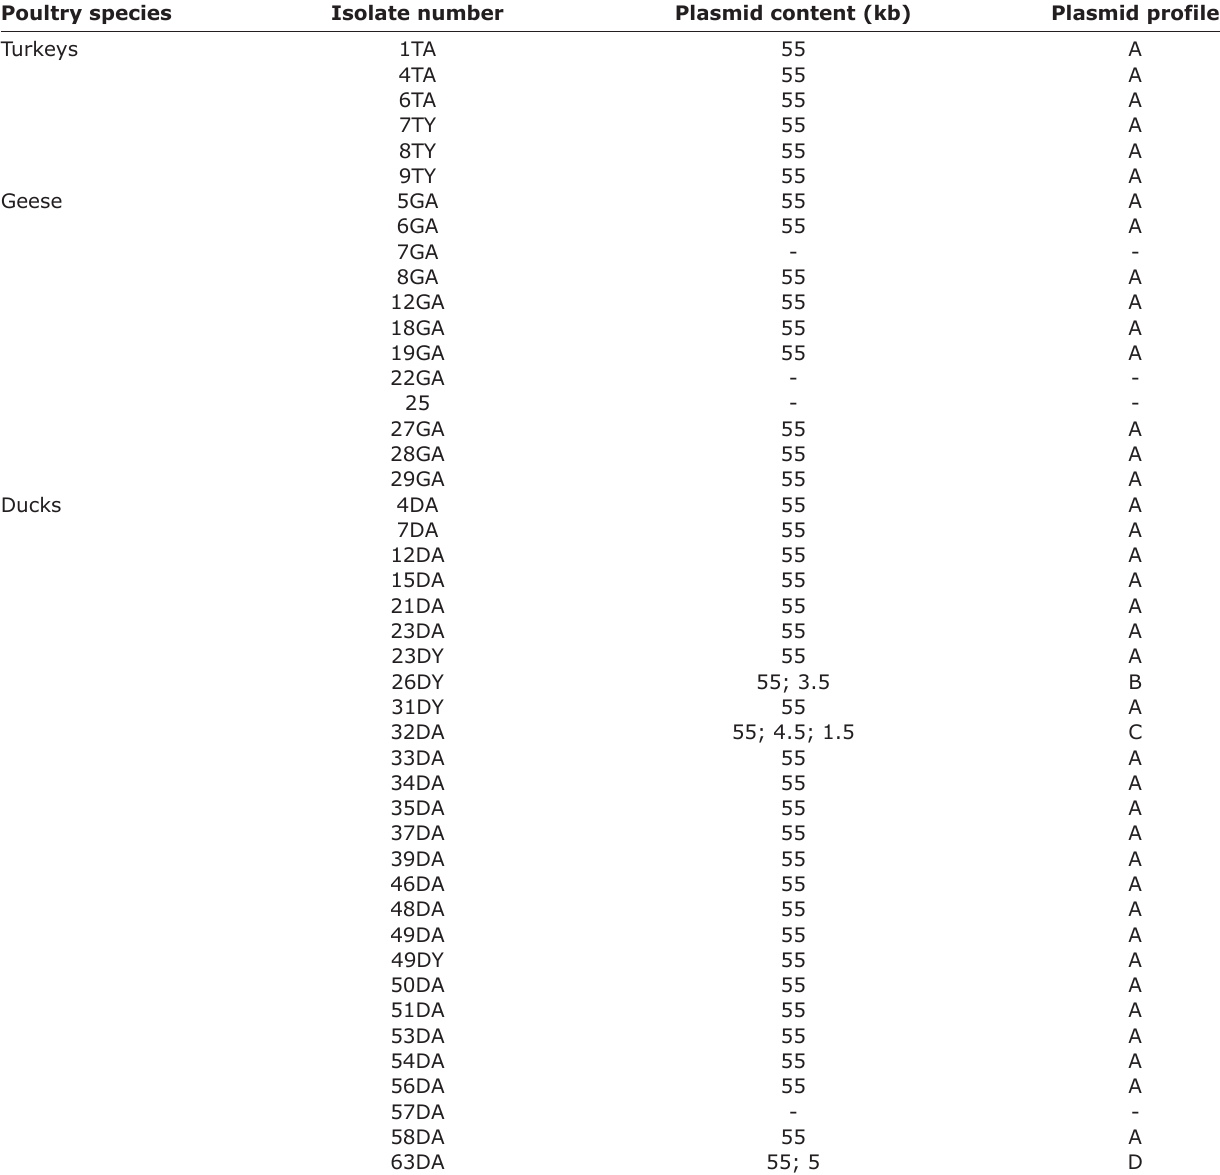
Table-4: Plasmid content and profiles in AFEC from turkeys, geese and ducks. Poultry species